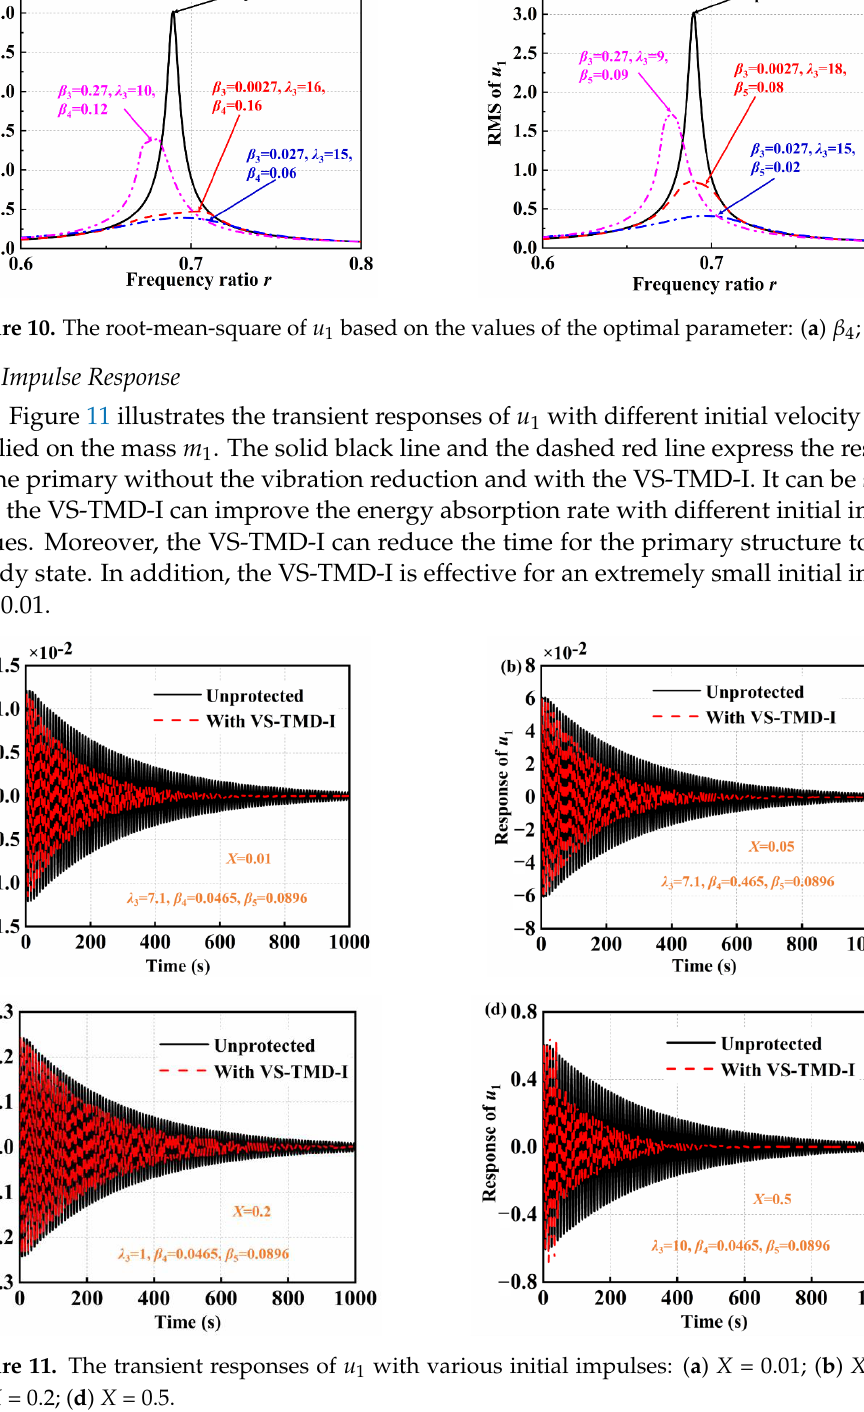
Figure 9. The resonant frequency change of the primary system as negative stiffness ratio β 5 and inertance ratio λ 3 under f e = 0.4 mm: ( a ) β 3 = 0.0027; ( b ) β 3 = 0.027; ( c ) β 3 = 0.27.